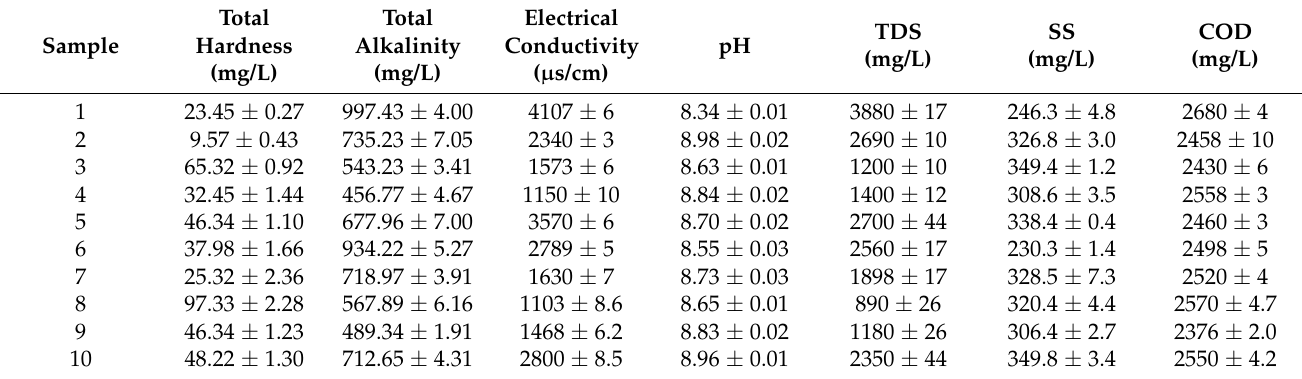
Table 1. Basic physical and chemical properties of water